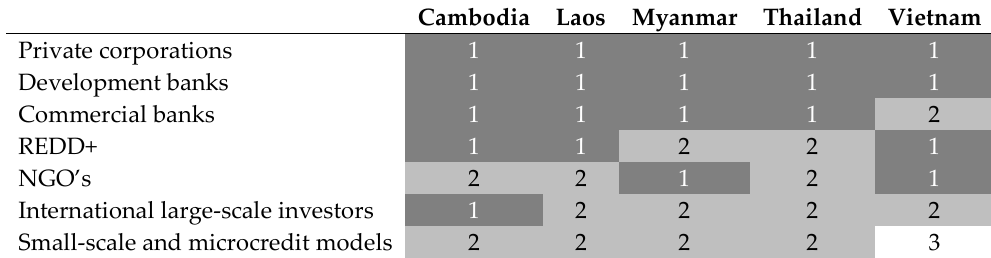
Table 6b. Long-term financing instruments of the proposed network, expressed by the ranked median values. 1 = very important, 2 = important, 3 = can be useful. Background colors represent classes